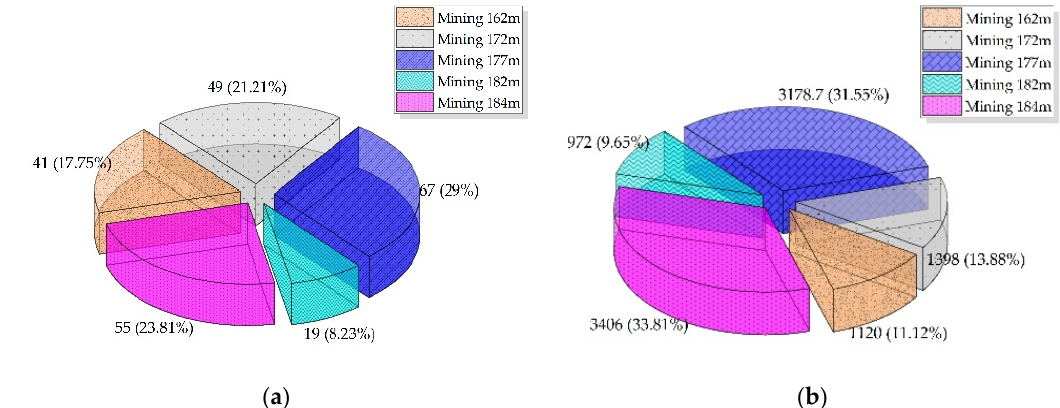
Figure 14. MS frequency and energy. ( a ) Frequency ratio of MS under different working face width; ( b ) MS energy ratio under different working face width conditions.